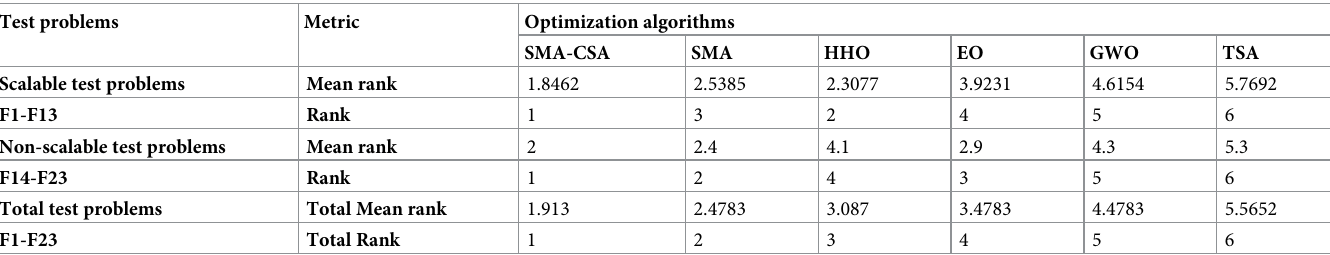
Table 9. Comparison results on Friedman’s ranking test with traditional